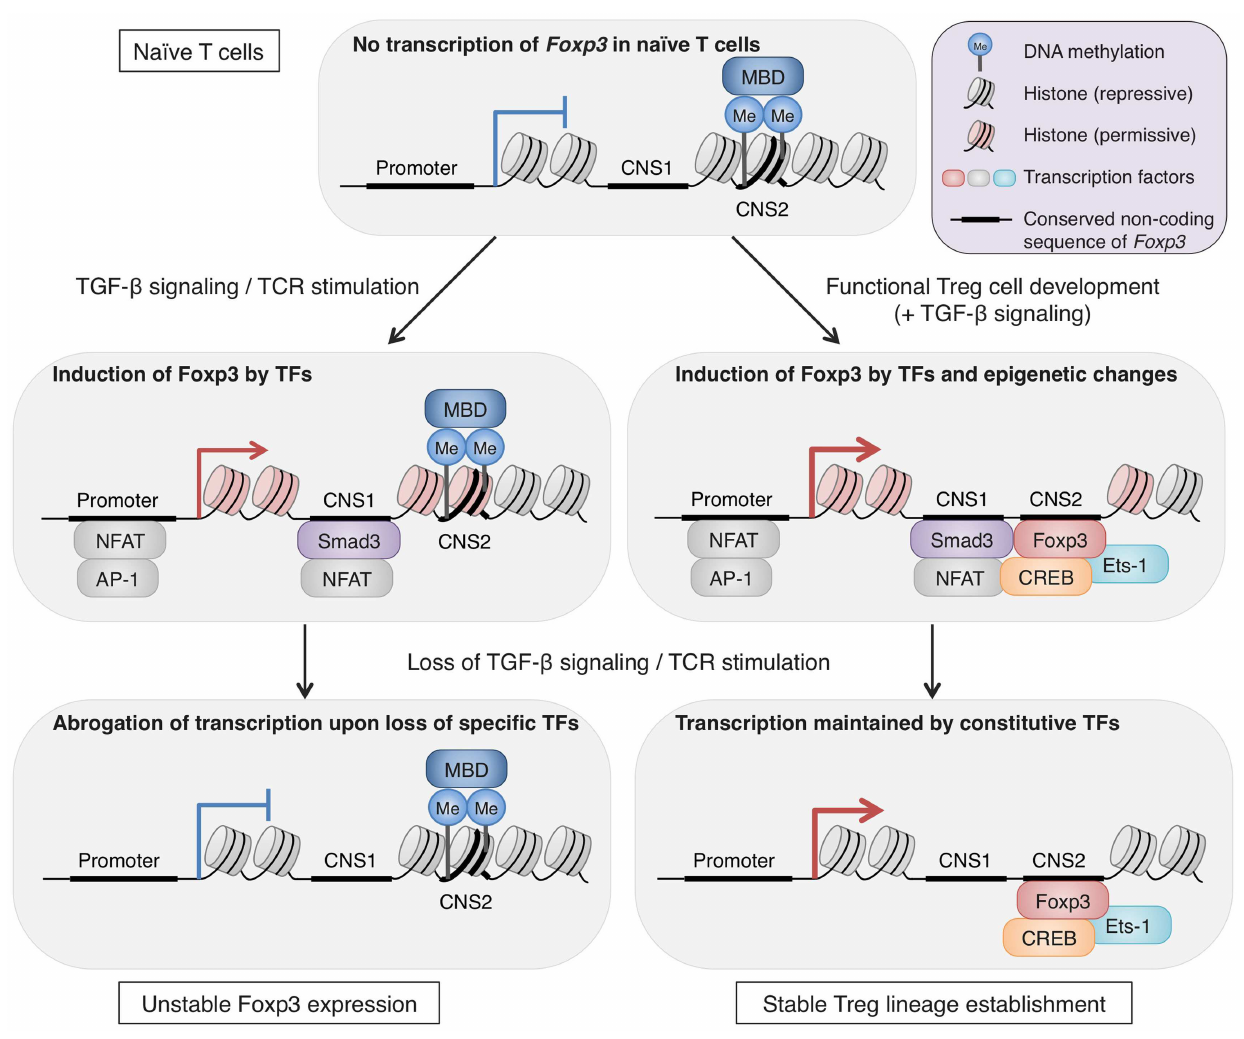
transcription factors such as Foxp3, Ets-1, and CREB.These epigenetic alterations are maintained irrespective of environmental changes and thus allow stable Foxp3 transcription by constitutively expressed transcription factors. In contrast, Foxp3 expression induced byTGF- β signaling andTCR stimulation in vitro is unstable.These signals induce transcription factors, such as NFAT, AP-1, and Smad3, which are capable of activating Foxp3 transcription, andTGF- β signaling can also alter histone modifications of the Foxp3 locus (Tone et al., 2008). However, these features cannot be maintained onceTGF- β signaling andTCR stimulation are lost, resulting in loss of Foxp3 transcription (Ohkura et al.,